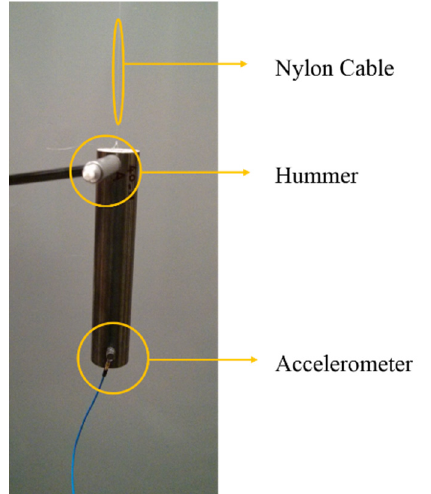
Figure 6. Experimental setup for free-free